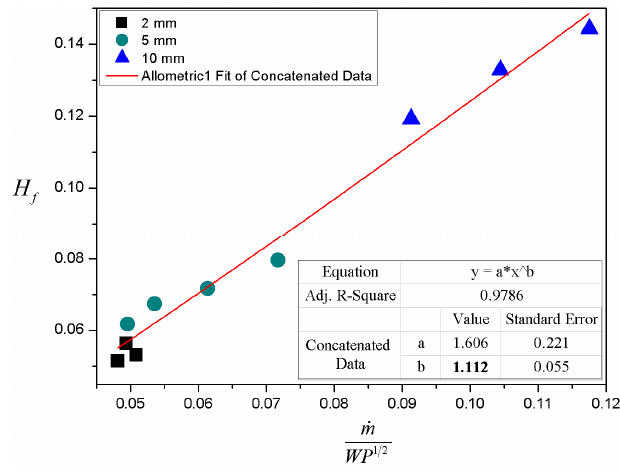
 m . m H to . The red line . The red line is f WP 1/2 1 2 WP